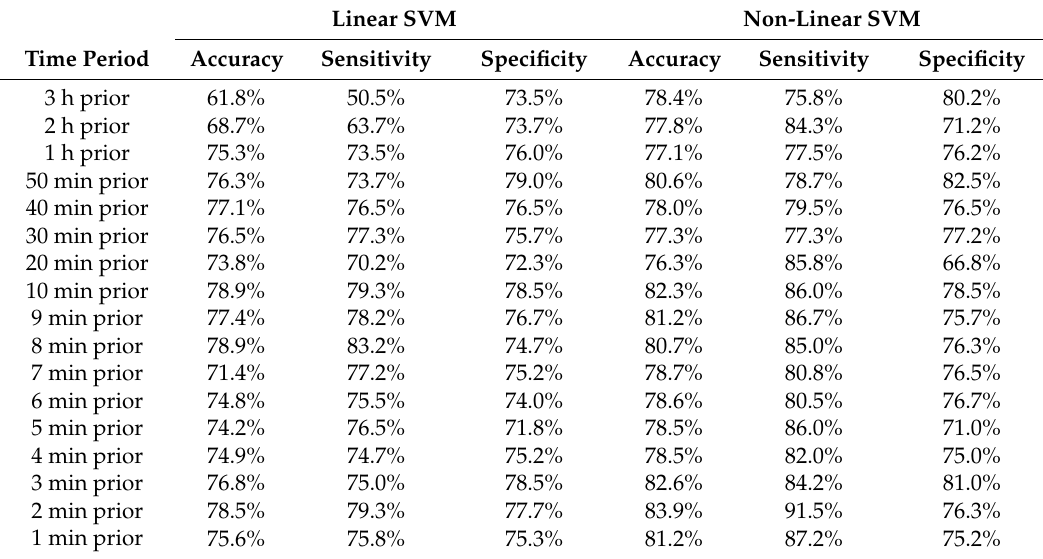
Table 2. Tabular summary of the accuracy, sensitivity, and specificity of the support vector